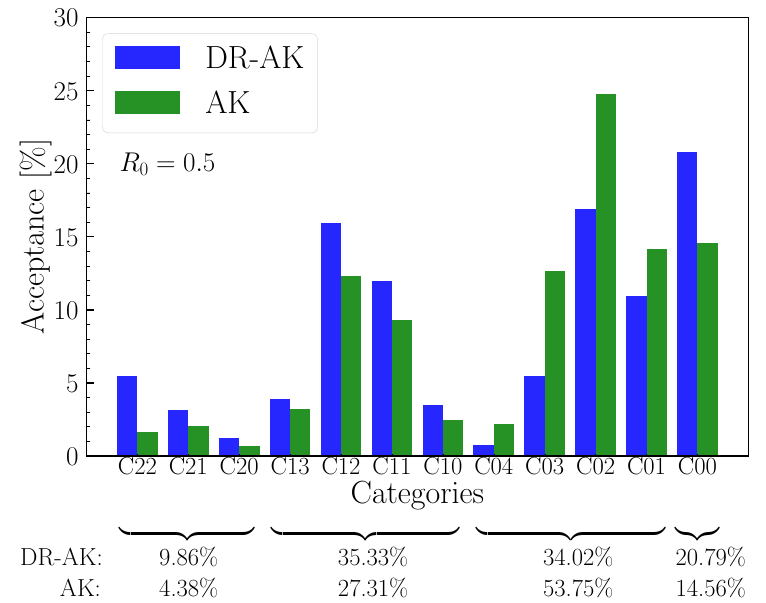
Figure 13 . Bar plot of A for different categories for jet algorithms with R 0 = 0 . 5 . The blue, and green bars are for DR-AK and AK algorithm respectively. From left to right, The numbers under the braces represent the values of A for the categories which capture 2 top , 1 top , 0 top , and none of the top or W